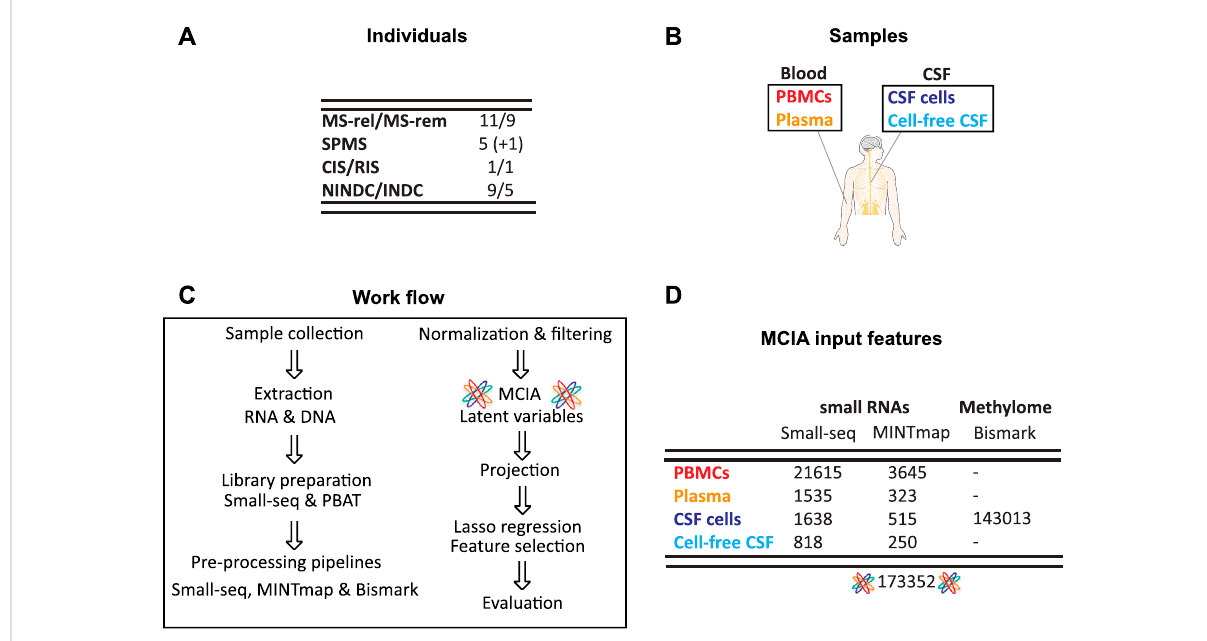
FIGURE 1 Cohort and sample overview. (A) Samples were collected from people with Multiple Sclerosis (MS) in relapse (MS-rel), remission (MS-rem), secondary progressive (SPMS), clinically and radiologically isolated syndrome (CIS/RIS) stages, in fl ammatory (INDC) and non-in fl ammatory neurological disease controls (NINDCs). (B) Blood and cerebrospinal fl uid (CSF) were collected from the same individual and separated into peripheral blood mononuclear cells (PBMCs), plasma, CSF cells and cell-free CSF. (C) Work fl ow. Upon DNA and RNA extraction, sequencing libraries were constructed using Small-seq and PBAT methodology, respectively. Sequencing reads were pre-processed, which includes QC, fi ltering,mapping,deduplication,andcoveragecount,usingthestandardSmall-seqandMINTmappipelinesforsmallRNAs,whereasthemethylome data was pro fi led using Bismark. After normalization and variance fi ltering, multiple co-inertia analysis (MCIA) was applied, SPMS samples were projected,andlatentvariablesweresubsequentlyextracted.Lassoregressionwasappliedforfeatureselectionfollowedbyevaluationofthereduced feature model. (D) Overview of features included in MCIA. The number of features for each source and methodology is given, as well as the total number of features included in downstream integration with